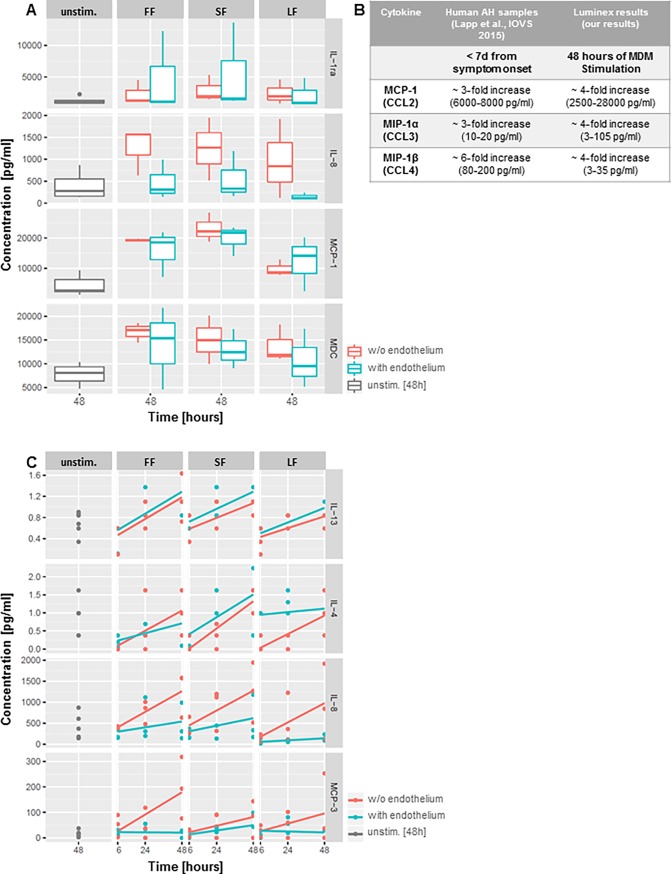
Cytokine patterns.(A) Examples of cytokine levels produced by MDM after stimulation with fragment-free supernatant fluid phase [FF], small [SF], and large corneal fragments [LF] with (blue) or without endothelium (red) or control media after 48 hours. Unstimulated MDM (supernatant collected after 48h) and untreated corneal tissue (without MDM-co-incubation) served as negative controls; MDM stimulated with LPS or IFNγ served as positive controls (only unstimulated control shown). (B) Cytokines in aqueous humor (AH) samples from patients during acute corneal graft rejection (duration of symptoms < 7 days; fold increase compared to AH samples from patients undergoing cataract surgery w/o history of other corneal pathologies), and in MDM supernatant after 48 hours of stimulation in vitro (fold increase related to six versus 48 hours of stimulation). (C) Time course of individual cytokine concentrations produced by MDM incubated with FF, SF, and LF; concentrations given for six, 24 and 48 hours of stimulation. The presence (blue) or absence (red) of corneal endothelium led to an increase of anti-inflammatory chemokines (IL-4 and IL-13) when endothelium was present during MDM-stimulation; vice versa to an increase of inflammatory / chemotactic cytokines (IL-8 and MCP-1) when corneal stroma without endothelium was used for MDM-stimulation.